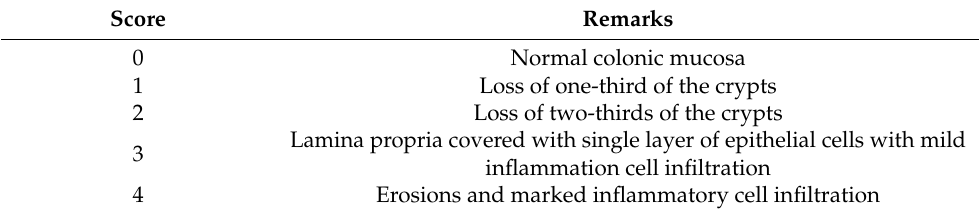
Table 2. Criteria for assessment of microscopic rectal